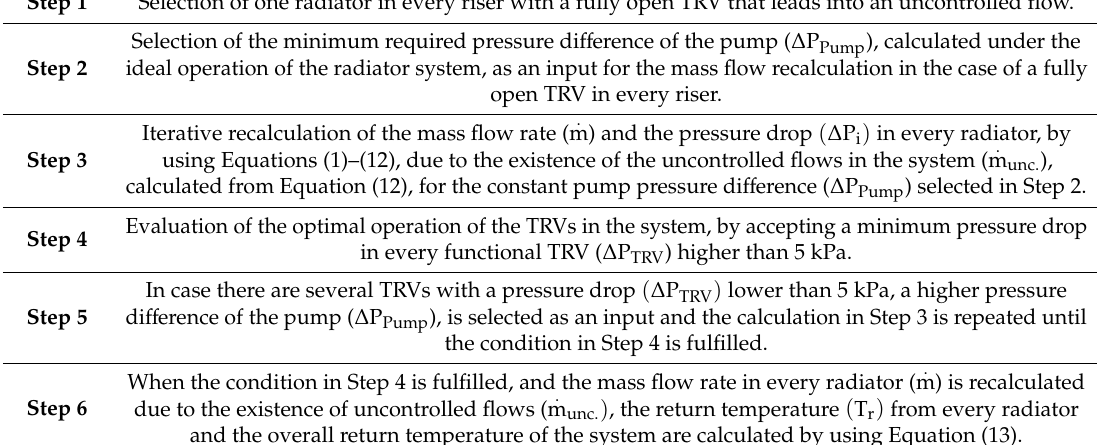
Table 3. An overview of the calculation process performed by the thermal-hydraulic model in order to recalculate the mass flow rate, the pressure di ff erence of the pump and the return temperature of the radiator system under the case of one problematic TRV in every riser that causes uncontrolled flows